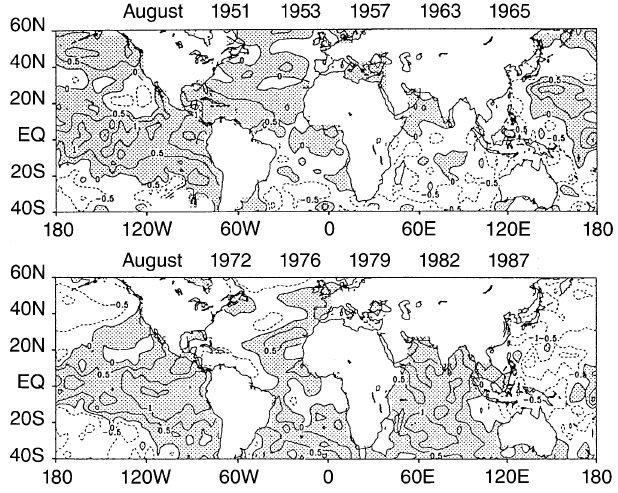
Fig. 1. Composite SSTAs (relative to the 1951 — 1990 mean) during ENSO warm events in August. Positive (negative) anomaly areas in grey ( white ) and solid ( dashed ) lines every 0.5 °